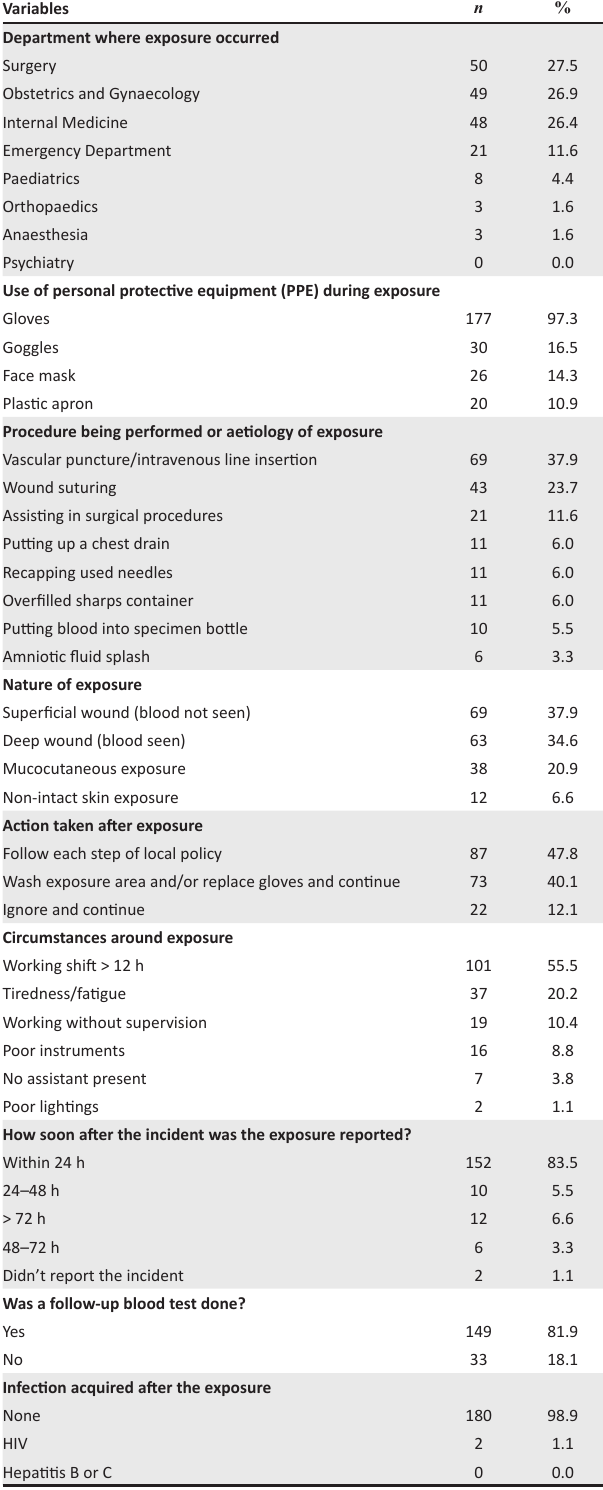
TABLE 2: Description of the 182 occupational blood or body fluid exposures amongst study subjects.